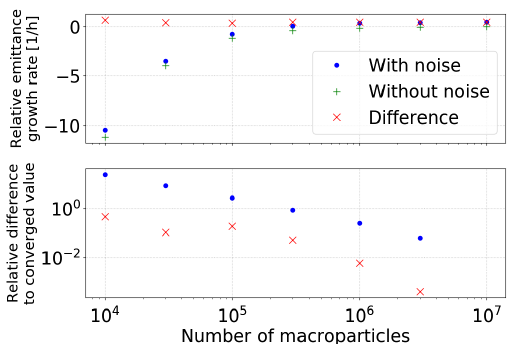
FIG. 2. The upper plot shows the relative emittance growth rate obtained with and without noise ( δ 0 ¼ 2 . 9 × 10 − 4 ), as well as the difference, for a simulation with the numerical parameters listed in Table I, a chromaticity of 15 units, a feedback gain of 0.02, a single IP and for different number of macroparticles. The lower plot illustrate the convergence of the method, by comparing to the respective value obtained with 10 7 macroparticles.